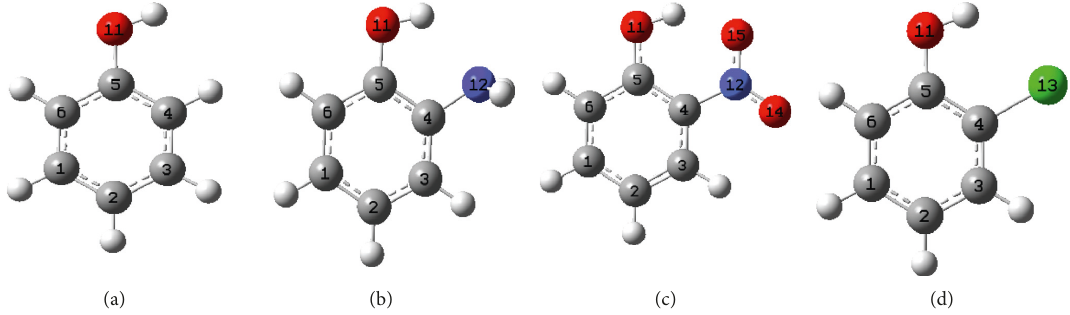
Figure 1: Molecular geometries of the phenols: (a) phenol; (b) 2-aminophenol; (c) 2-nitrophenol; (d)